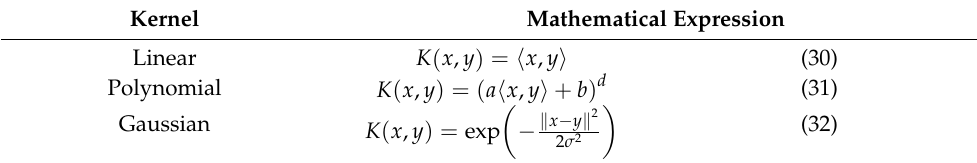
Table 1. Types of